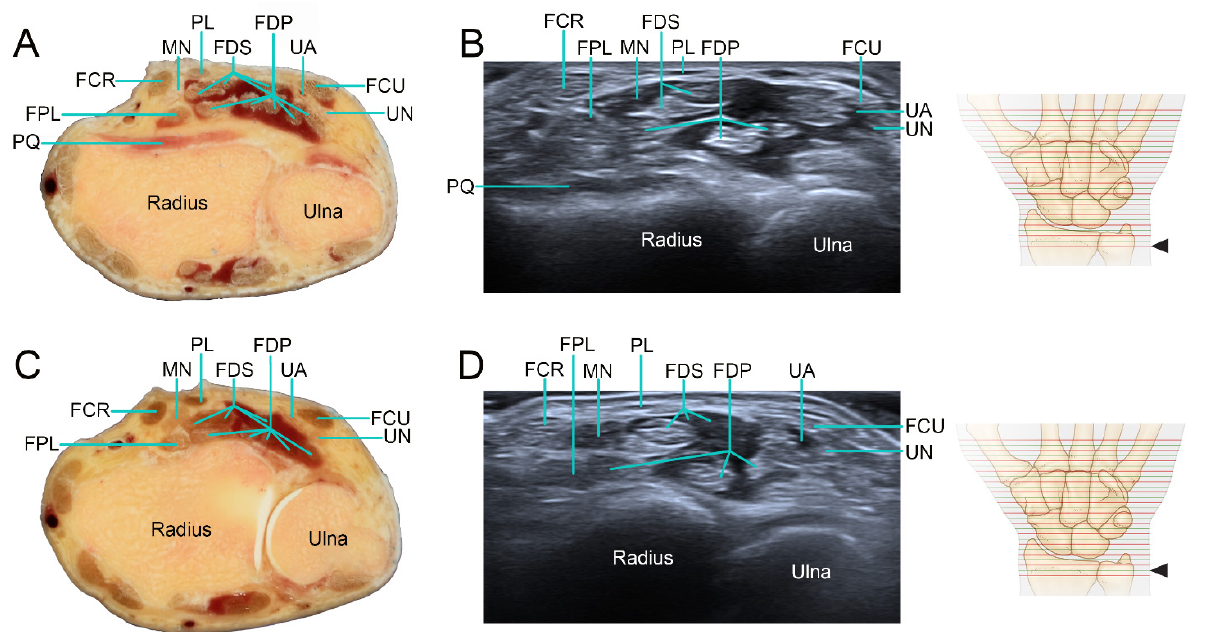
Figure 2. Sectioned images ( A , C ) and corresponding ultrasound (US) ( B , D ) images for transverse views at the distal radius (Rad) and ulna. ( A , B ) The pronator quadratus (PQ) is anterior to the distal Rad . The flexor carpi radialis (FCR) and flexor carpi ulnaris (FCU) tendons are located at the radial and ulnar sites on the palmar wrist beneath the skin, respectively. The flexor digitorum superficialis (FDS) and flexor digitorum profundus (FDP) tendons are in two layers in the anterior compartment of the forearm. The flexor pollicis longus (FPL) tendon is radial to the FDP tendons. The palmaris longus (PL) tendon is superficial to and on the ulnar side of the median nerve (MN). The MN is just anterior to the FPL tendon, radial to the FDS tendons. The ulnar artery (UA) and ulnar nerve (UN) are between the fourth and fifth FDS and FCU tendons. ( C , D ) At a more-distal level of the distal Rad and ulna, the distal radioulnar joint is observed. The PQ disappears, and the other structures are at sites similar to those in panels A and B. Arrowheads in the schematics indicate the levels of the wrist scanned by the US